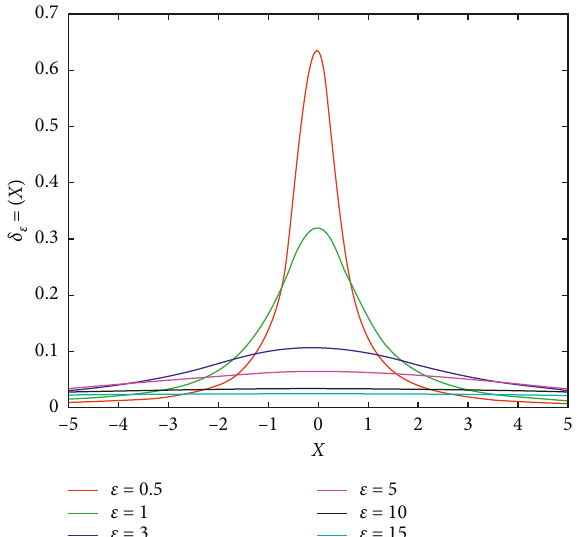
Figure 9: The change curve of the function δ